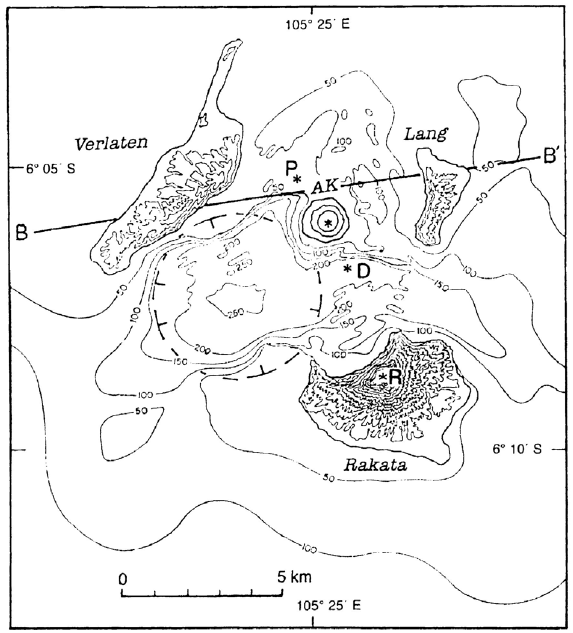
Figure 6. Topographic and bathymetric chart on and around Krakatau: a part of Indonesian Chart around Krakatau Islands sur- veyed in 1940. The isobaths are drawn every 50 m and the contour intervals every 20 m. AK Anak Krakatau, R Rakata, D Danan, P Per- buwatan. A circle of broken line shows the assumed caldera